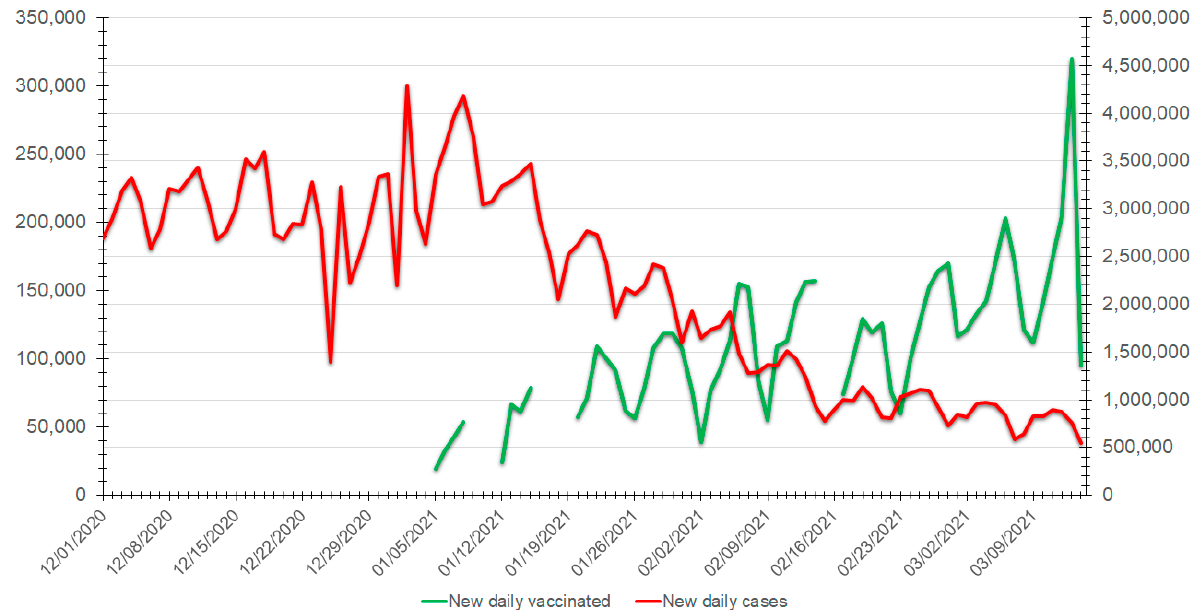
Figure 1. Evolution over time (between 1 December 2020 and 15 March 2021) of the number of new daily positive COVID-19 cases (left axis, red line) versus the number of new daily individuals vaccinated against COVID-19 (right axis, green line).